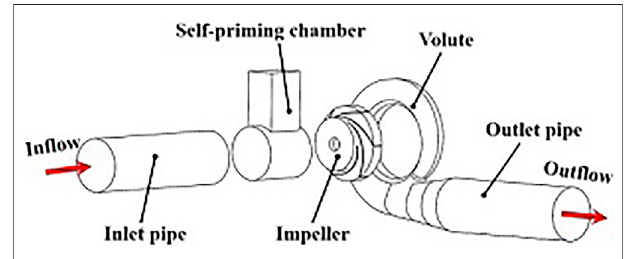
FIGURE 1 | The calculation model of the self-priming pump.